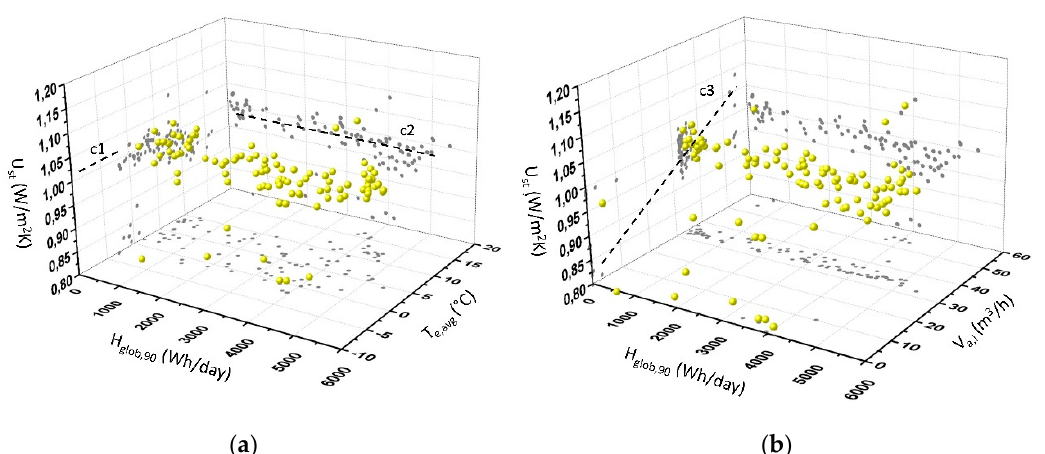
Figure 9. Static thermal transmittance U st of the glazed BIPV façade structure with a forced ventilated air gap; ( a ) impact of the daily solar radiation H glob,90 received by the BIPV façade structure and average daily outdoor air T e,avg (equal to the temperature of the ventilation air at the inlet of the air gap); ( b ) impact of the solar radiation and ventilation air flow rate V a,i .